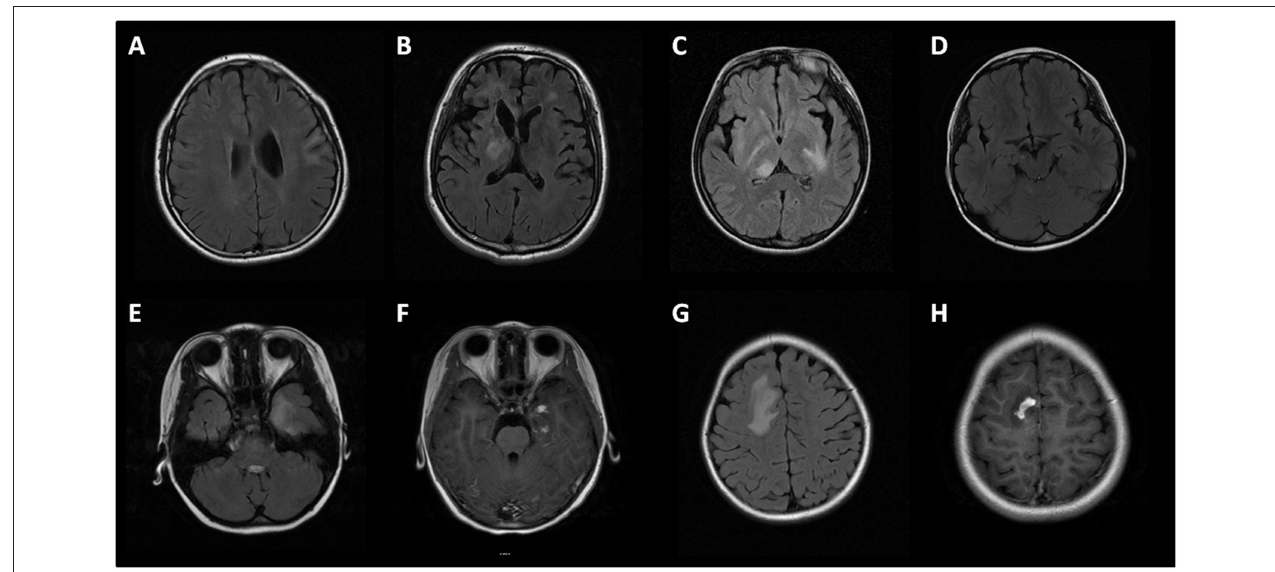
FIGURE 3 | Brain MRI of MOG-IgG positive patients with seizures and/or encephalopathy. (A) Cortical and subcortical lesions; (B) Deep white matter lesions and periventricular lesions; (C) Thalamus lesions; (D) Cerebral peduncle lesions; (E,G) Large white matter lesions of a patient in temporal lobe and parietal lobe, with prominent gadolinium enhancement (F,H)